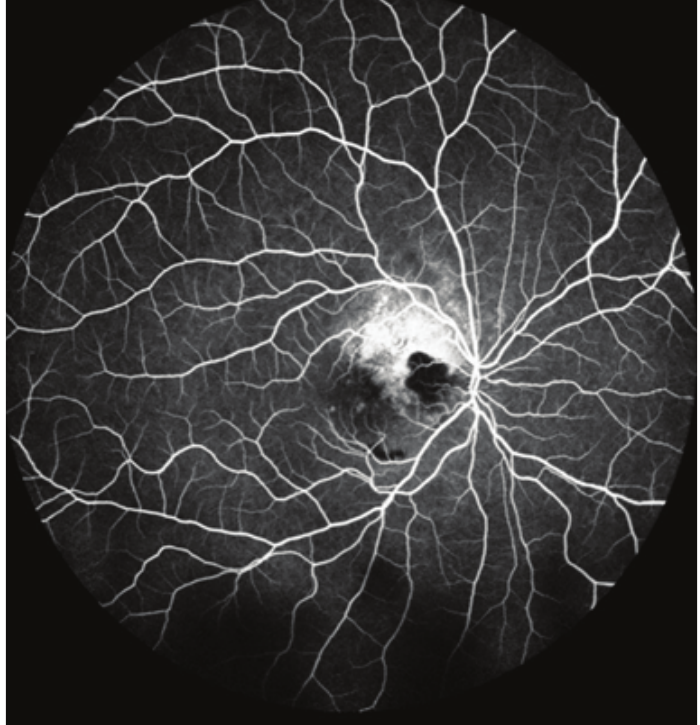
Figure 3. Fluorescein angiography (FAG) showing choroidal neovascularization in the right eye.